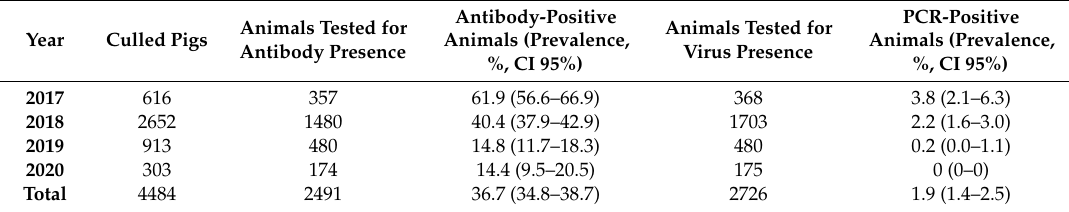
Figure 1. Map representing the Sardinian municipalities of the free-ranging pig culling actions (blue and red dots). The 55234/18 and the 103917/18 were isolated from samples collected in Desulo and Talana (red dots), both inside the wild boar infected zone (red line). Table 1. Information on number of culled pigs, African swine fever virus (ASFV) antibody and virus prevalence in free-ranging pigs tested in Sardinia from December 2017 to February 2020.